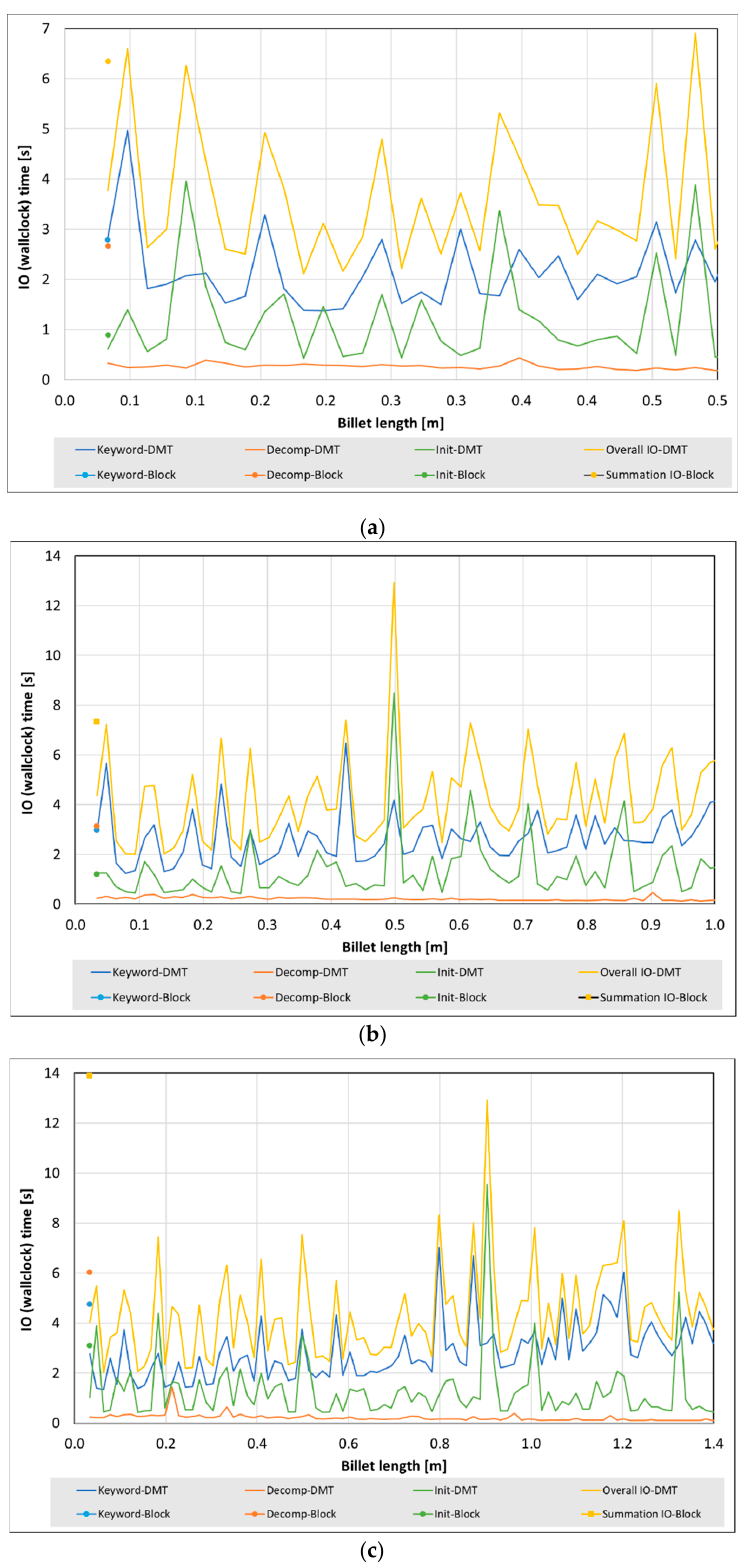
Figure 11. Comparison of variation of IO processing time for DMT using four computing nodes (with 16 cores each) for billet lengths ( a ) 0.5 m; ( b )1.0m; and ( c ) 1.4 m.